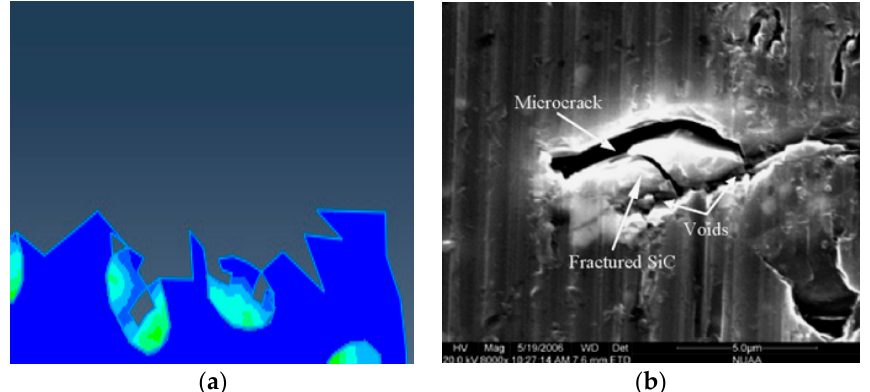
Figure 17. SiC particle cut morphology: ( a ) Simulation of particle cut off, ( b ) particle crushed and partial cut off morphology in actual processing. ( b ) Adapted with permission from ref. [37] Copyright 2008, Elsevier.